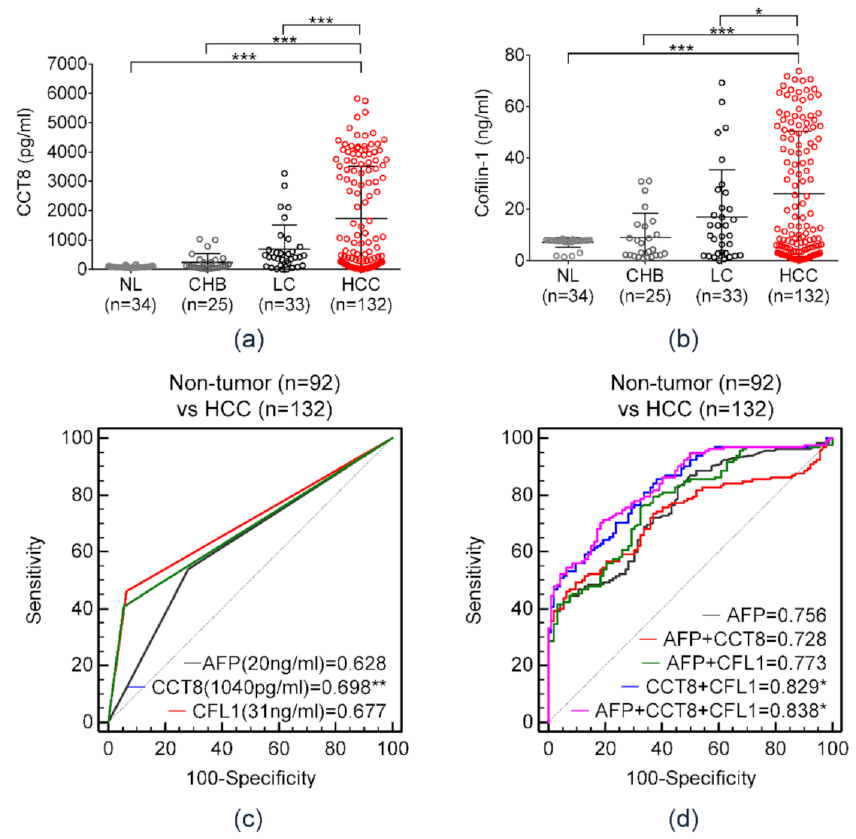
Figure 5. Diagnostic significance of serum AFP, CCT8, and CFL1 in diagnosing HCC in the validation cohort comprised of 34 normal individuals, 25 patients with chronic hepatitis B, 33 patients with liver cirrhosis, and 132 patients with HCC. ( a , b ) Expression level of serum ( a ) CCT8 and ( b ) CFL-1 according to clinical liver disease status. (Welch’s t -test; * p < 0.05, ** p < 0.01, *** p < 0.001) ( c ) AUC of serum AFP and two serum protein markers in diagnosing HCC. (Welch’s t -test; ** p < 0.01) ( d ) Diagnostic performance of serum protein panels for hepatocellular carcinoma in the validation cohort. (Welch’s t -test; * p <